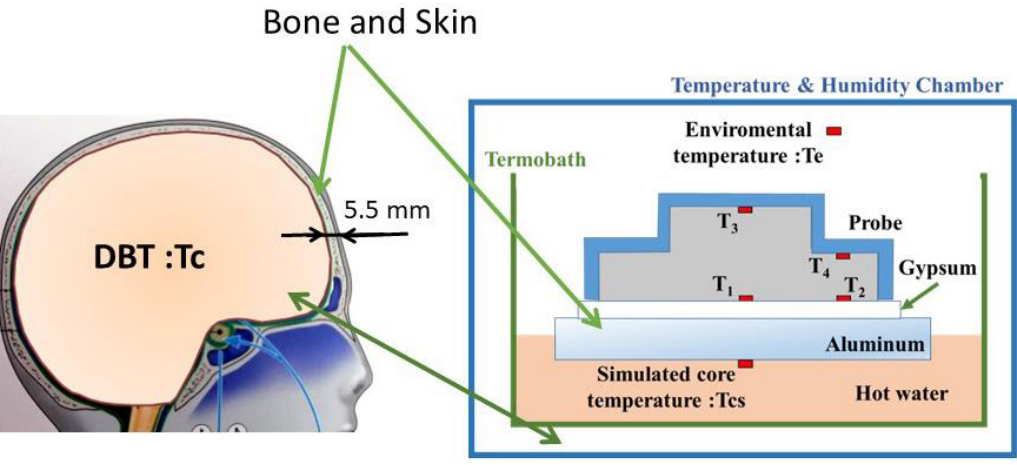
Figure 5. Calibration device mimicking the forehead.